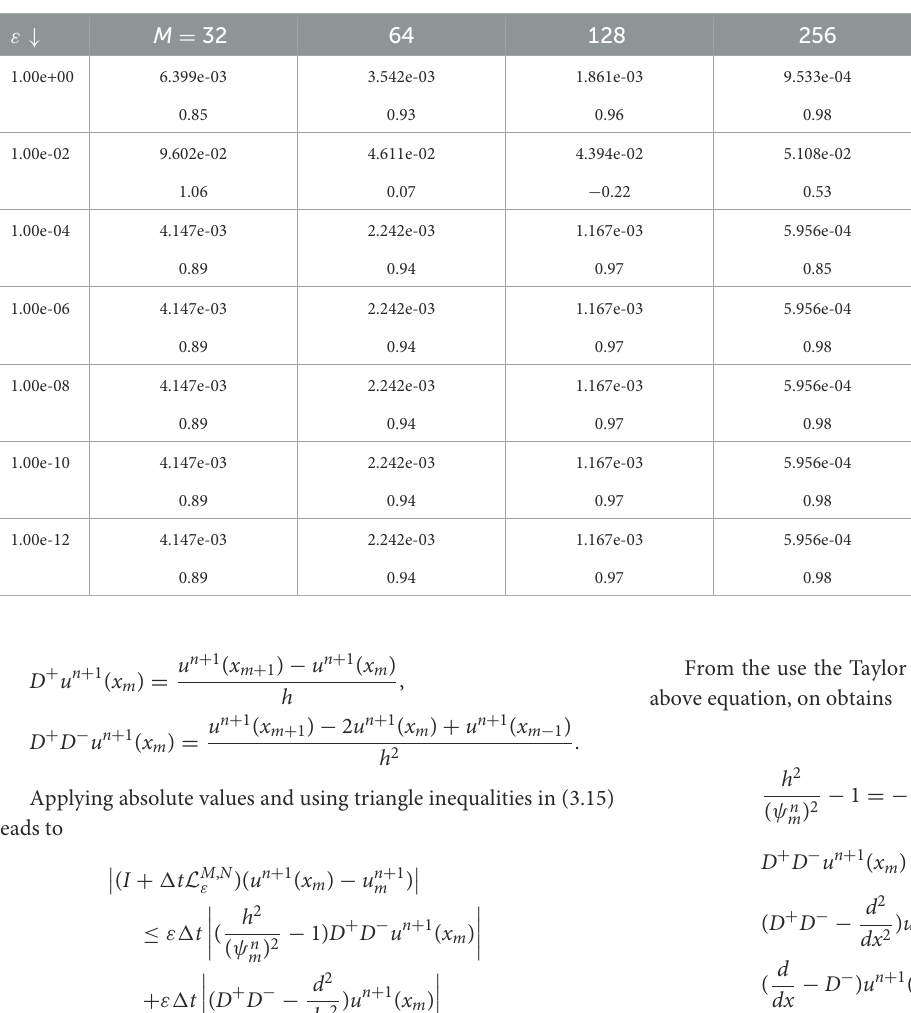
TABLE 6 Maximum absolute errors for Example 4.2 for N = 10 at the number of intervals M